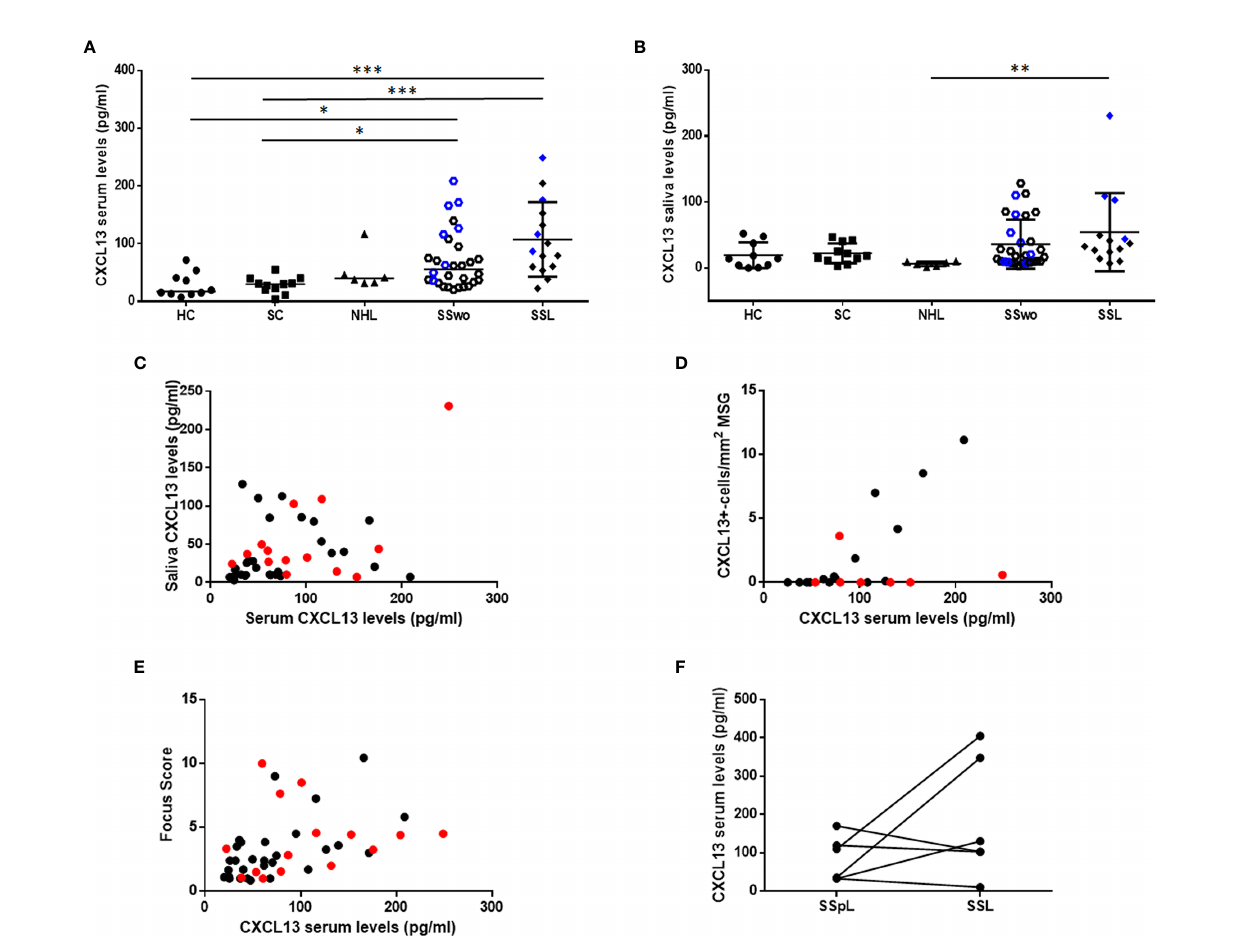
FIGURE 2 | CXCL13 serum and saliva levels. (A) Dot plot displaying Kruskal-Wallis analysis of CXCL13 serum levels in healthy individuals (HC), sicca-complaining controls (SC), non-SS NHLs (NHL), pSS patients without evidence of NHL (SS) and pSS patients with NHL (SSL). (B) Dot plot representing Kruskal-Wallis analysis of CXCL13 saliva levels in healthy individuals (HC), sicca-complaining controls (SC), non-SS NHLs (NHL), pSS patients without evidence of NHL (SS) and pSS patients with NHL (SSL). P-values are designated by asterisks (*p < 0.05, **p < 0.01, ***p < 0.001), whereas horizontal bars represent the mean value of the group. Only statistically signi fi cant associations are indicated. CXCL13 serum and saliva levels from patients with ectopic germinal centers (eGCs) in the MSG in fi ltrates in panels (A, B) are highlighted by blue color. (C – E) Spearman ’ s rank correlation analysis of associations between: (C) serum and saliva CXCL13 levels (r=0.368, p=0.014), (D) serum CXCL13 levels and number of CXCL13+-cells per tissue area (mm 2 ) in MSG tissues (r=0.534, p=0.011), (E) serum CXCL13 levels and biopsy focus score (r=0.644, p< 0.0001) in pSS patients. Red color designates samples obtained from pSS patients with NHLs. (F) Wilcoxon ’ s matched-pair analyses of CXCL13 levels in sequential serum samples from 6 pre-lymphoma pSS patients (SSpL) that transitioned to NHL (SSL) did not reveal any signi fi cant changes in CXCL13 expression levels before and on NHL